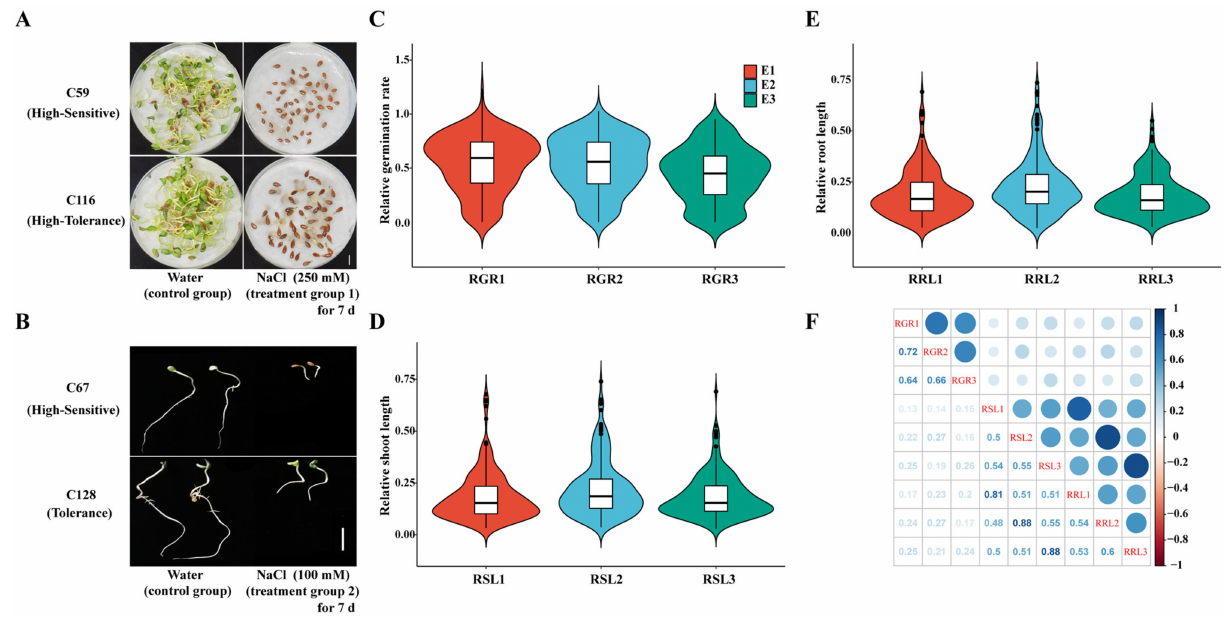
Figure 1. Phenotypic variation and correlation analysis of RGR, RSL and RRL traits. ( A , B ) Phenotypic diversity under salt stress during the germination stage; ( A ) Difference of GR under Salt Stress; ( B ) Difference of SL and RL under Salt Stress. Phenotype of flax accessions after 7 days of control and salt treatment. The photographs show representative seedlings. Scale bar, 1 cm; ( C – E ) Violin plot of phenotypic indexes; ( C ) RGR; ( D ) RSL; ( E ) RRL; ( F ) Correlation of all traits and environmental repeats. RGR1, RSL1 and RRL1 in environment 1 (E1). RGR2, RSL2 and RRL2 in environment 2 (E2). RGR3, RSL3 and RRL3 in environment 3 (E3).